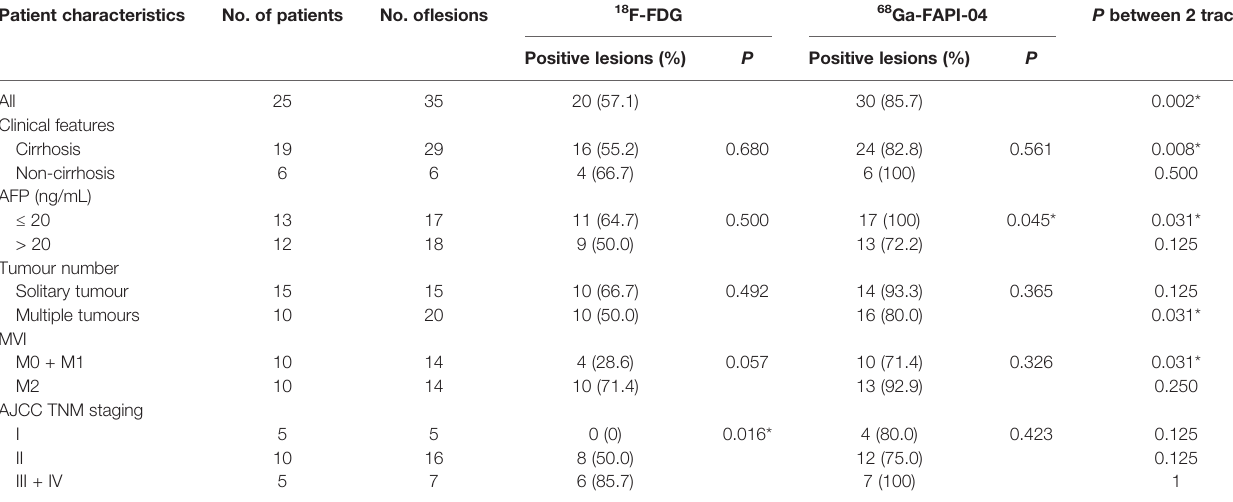
TABLE 2 | Sensitivities of 18 F-FDG and 68 Ga-FAPI-04 PET/CT in patient-based